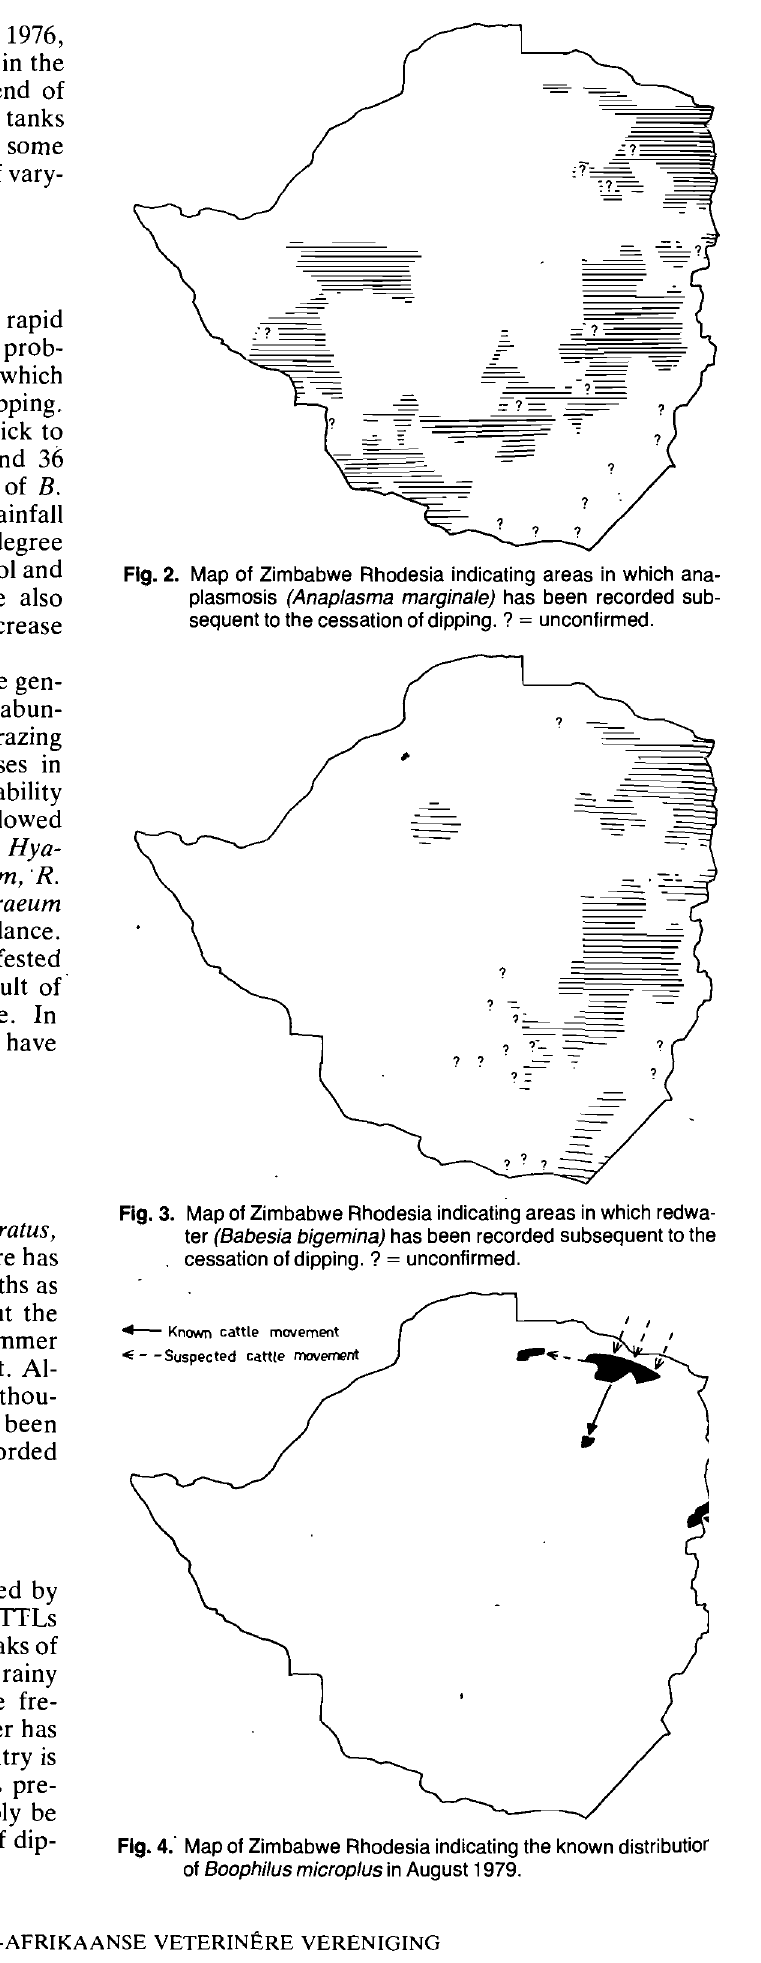
Fig. 4: Map of Zimbabwe Rhodesia indicating the known distributior of Boophilus microplus in August 1979.